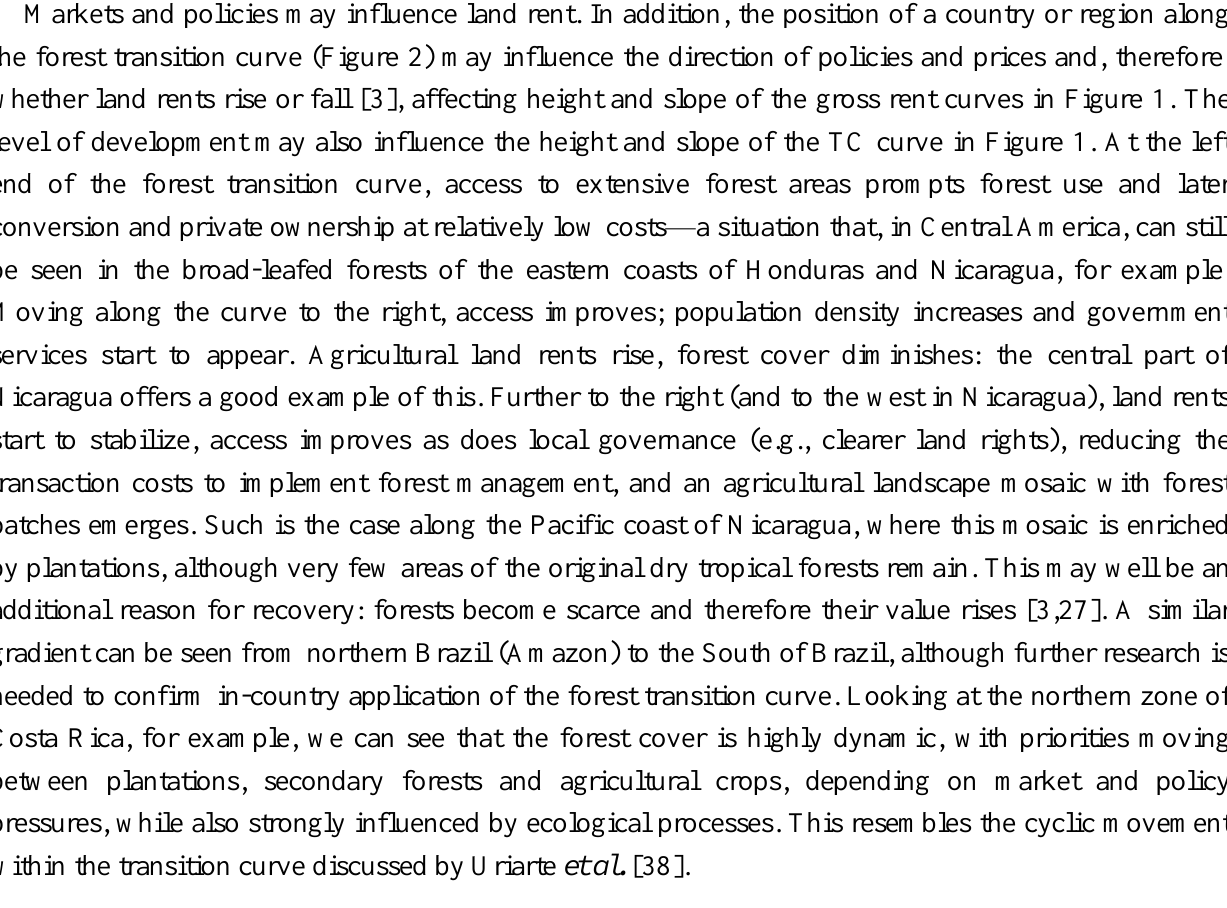
Figure 2. The forest transition curve, adapted from